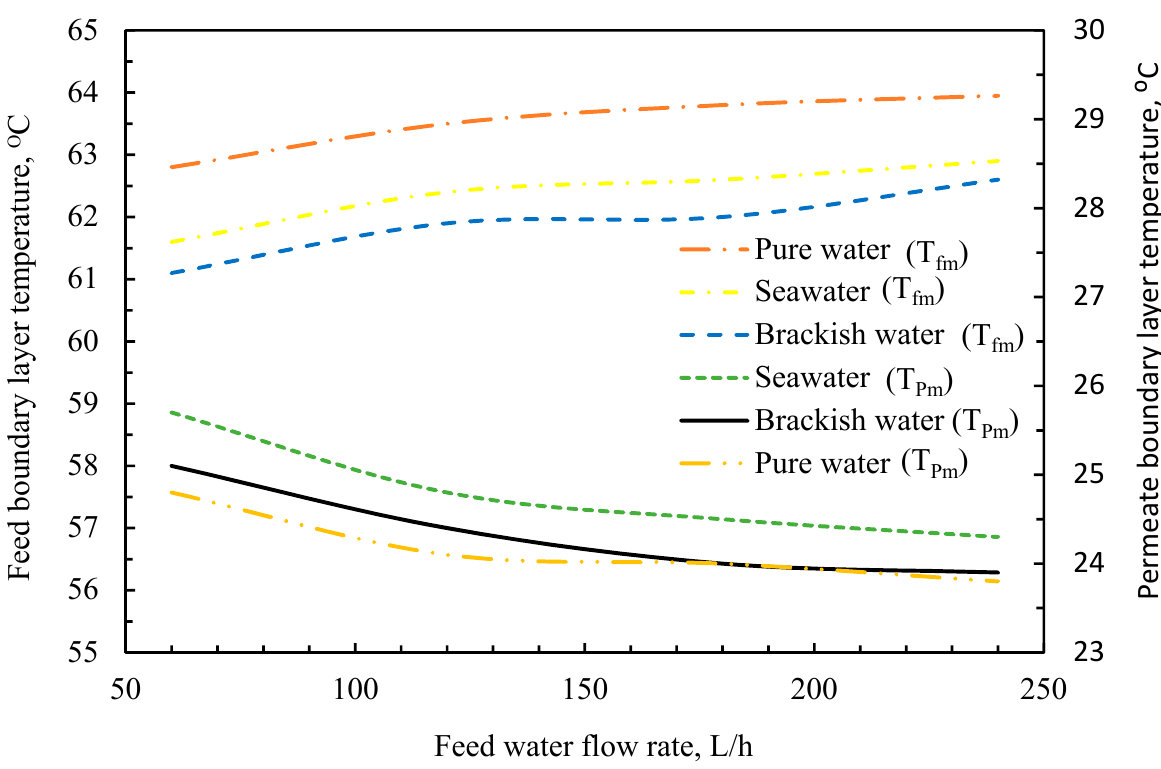
Figure 12. Feed membrane surface temperature versus feedwater flow rate.